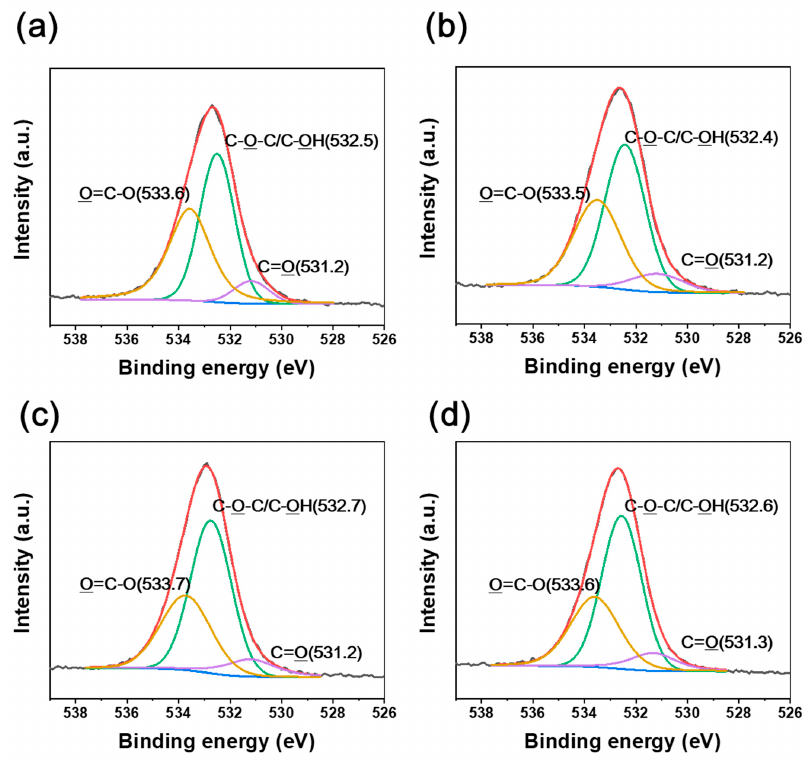
Figure 9. O1s XPS spectra of CF irradiated at ( a ) 3.4 kGy/s, ( b ) 6.8 kGy/s, ( c ) 13.5 kGy/s, and ( d ) 27 kGy/s absorbed dose rates.